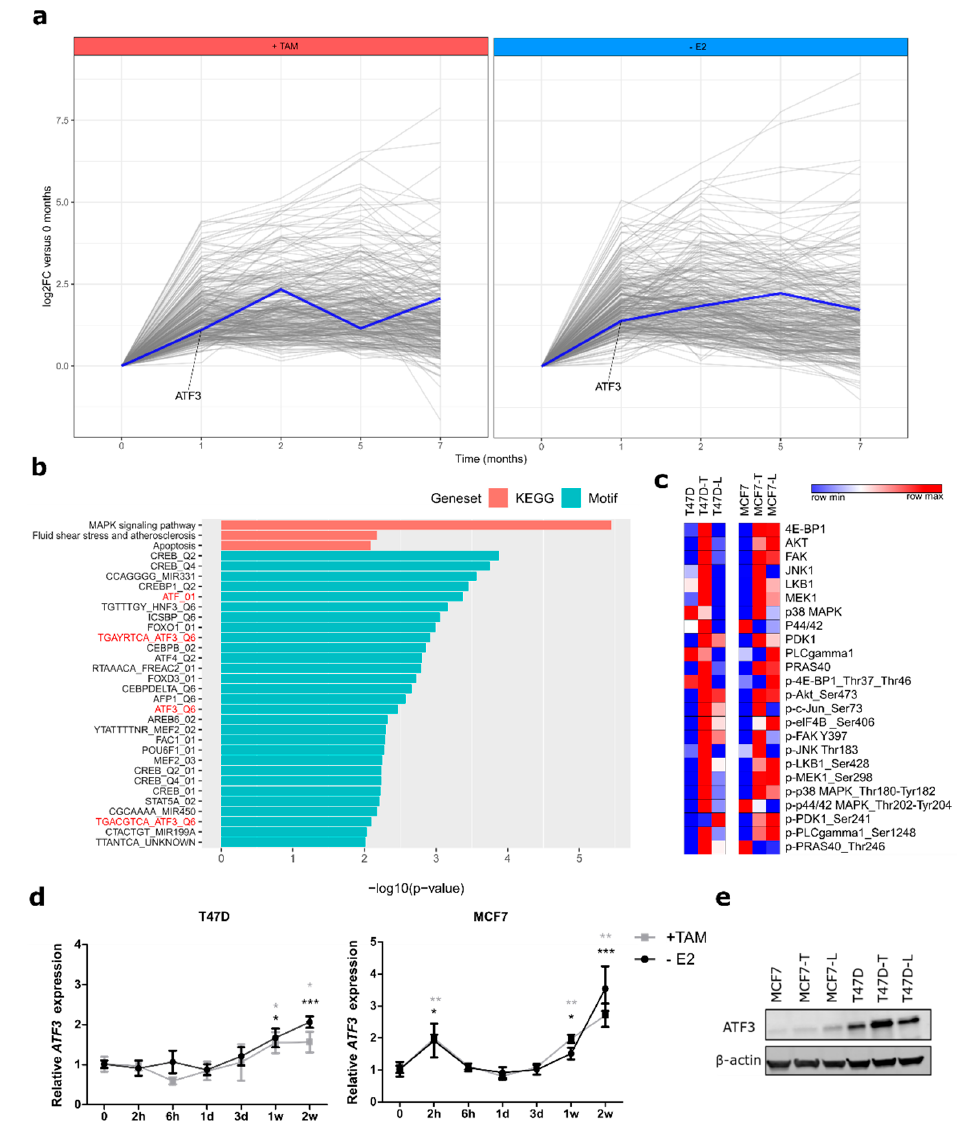
Figure 1. Time-resolved profiling identifies activating transcription factor 3 (ATF3) upregulation in early stages of resistance development. ( a ) Differentially upregulated genes after one or two months of treatment of T47D with 4-hydroxytamoxifen (TAM) (left panel) or E2 deprivation (right panel). ATF3 profile is highlighted in blue. RNA-seq values are represented as relative Log2 Fold Change compared to parental cells ( b ) Red: pathway enrichment analysis on the 282 commonly upregulated genes between TAM-treated and E2-deprived cells using KEGG (Kyoto Encyclopedia of Genes and Genomes) pathways. Blue: putative transcription factors binding analysis on the 282 commonly upregulated genes between TAM-treated and E2-deprived cells using Molecular Signature Database C3 motifs collection. ( c ) Heatmaps of 24 total proteins and phospho-proteins involved in MAPK and PI3K/AKT signaling pathways in T47D and MCF7 sensitive and resistant cells. Log2 normalized signal intensities for each protein are plotted and color-coding refers to relative intensities in each row independently. ( d ) Relative ATF3 mRNA levels determined by qRT-PCR in T47D and MCF7 treated for two weeks with either TAM or E2 deprivation. ( e ) ATF3 protein levels in sensitive and resistant T47D and MCF7 determined by WB after 2h anisomycin stimulation. β -actin levels are used as loading control. qRT-PCR data are normalized to ACTB and then to untreated cells and represented as mean + SEM, n = 3. *** p -value < 0.001, ** p -value < 0.01, * p -value < 0.05.